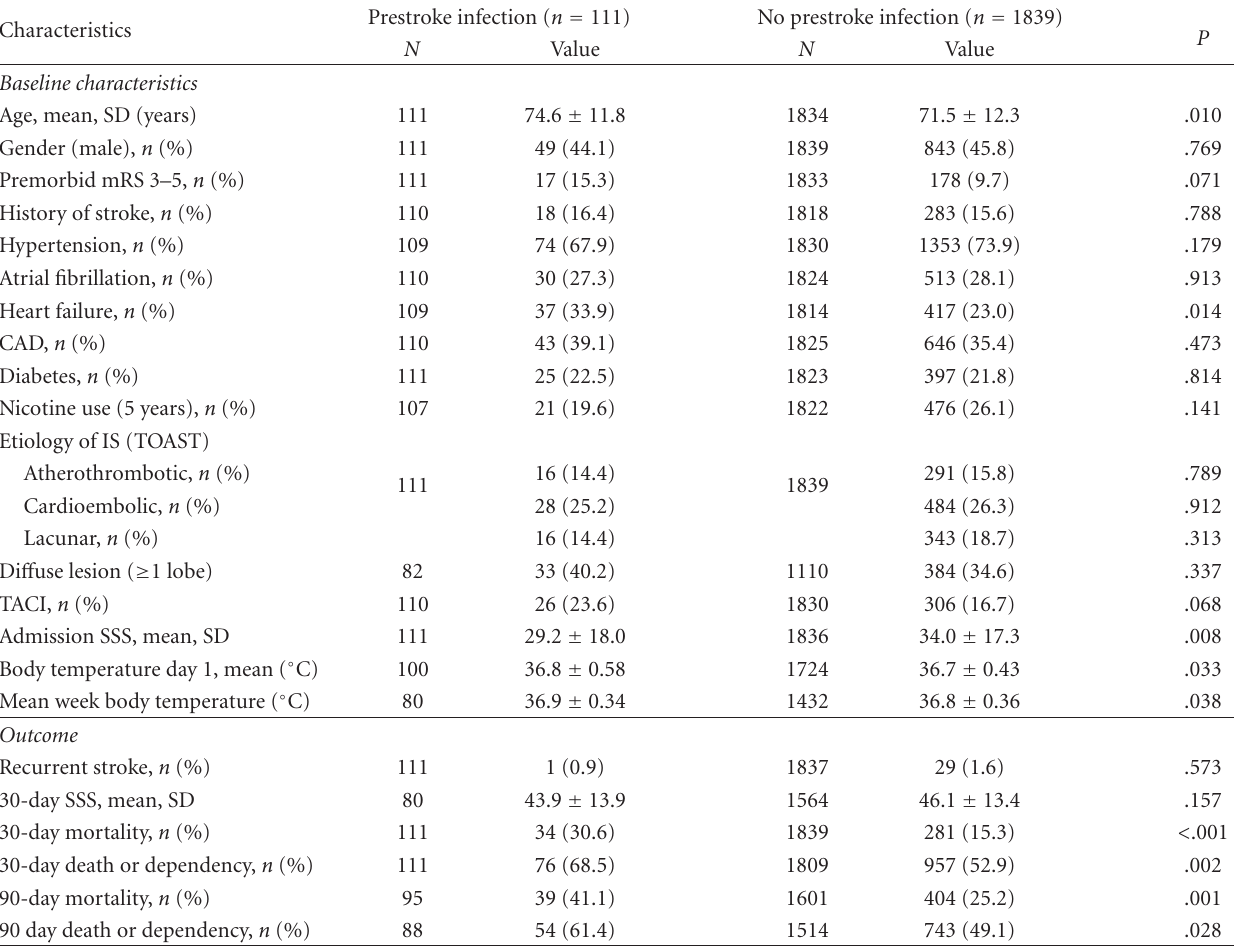
Table 1: Characteristics of patients with or without prestroke